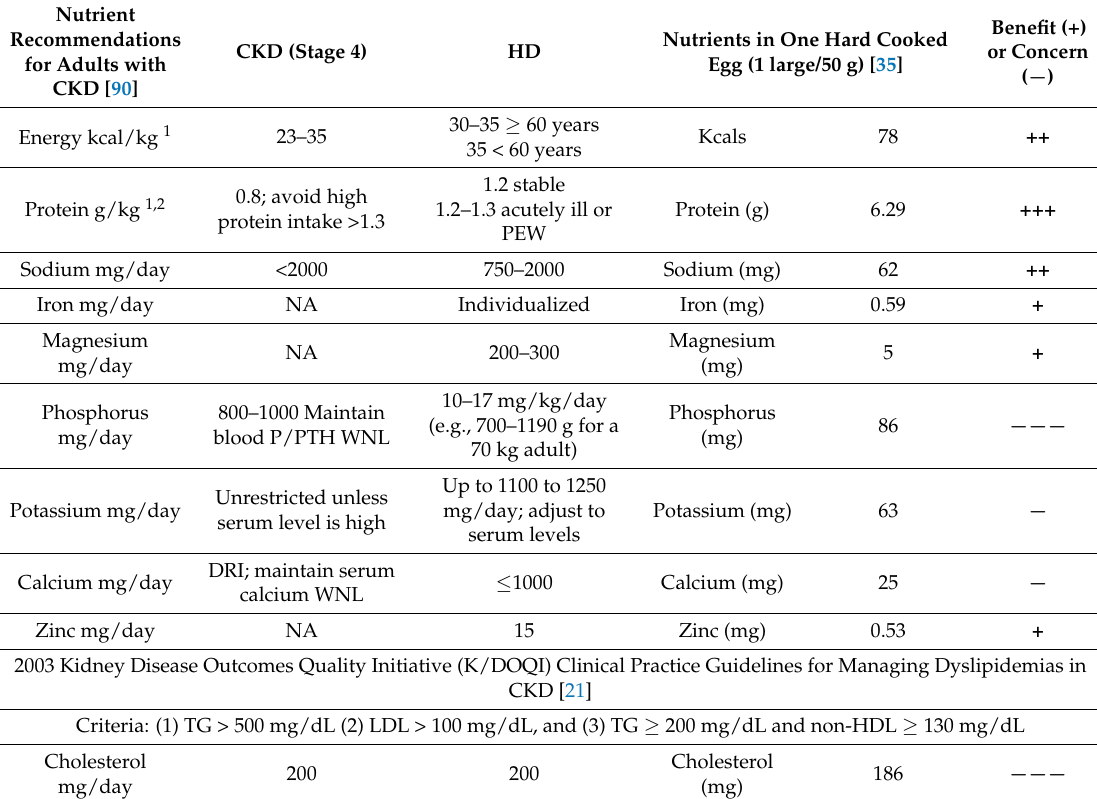
Table 2. Nutrients in one egg as compared to nutrient recommendations for adults with